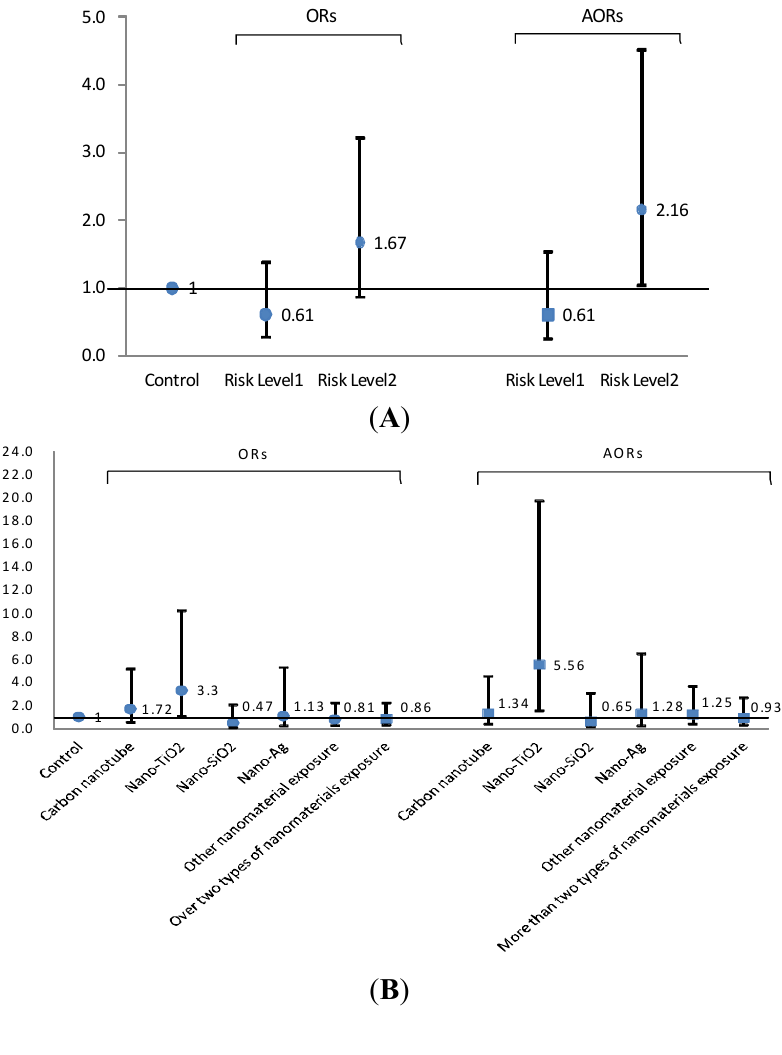
Figure 1. The odds ratio of risk levels ( A ) and by nanomaterials exposure ( B ) in fractional exhaled nitric oxide (FENO) values > 90th percentile (35 ppb) of all 437 study subjects. [AOR: adjusted odds ratios for gender (male vs . female), cigarette smoking (yes vs . no), exercise before tests (yes vs . no), asthma (yes vs . no), allergic rhinitis (yes vs . no), LnNF- κ B (EBC), and PEFR